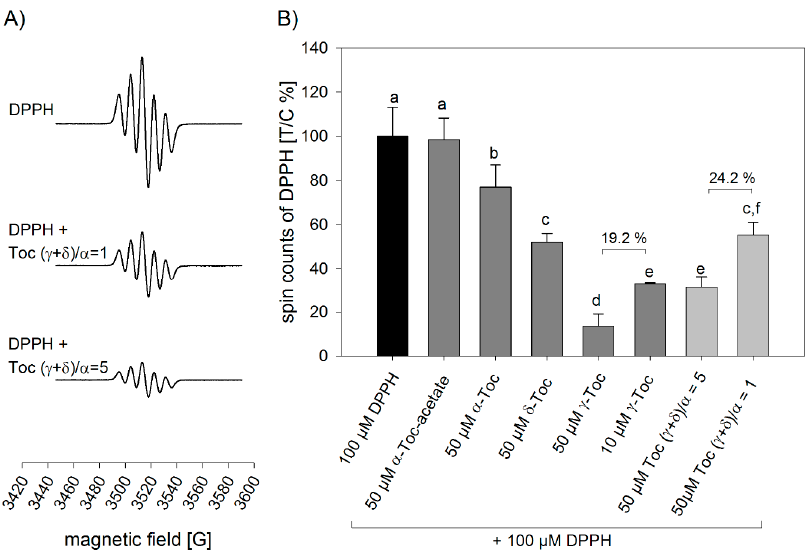
Figure 3. ( A ) ESR signals of DPPH and DPPH radical scavenging activity of 50 µM tocopherol ratio ( γ + δ )/ α = 1 and 50 µM tocopherol ratio ( γ + δ )/ α = 5 and ( B ) spin counts of DPPH. After three minutes spin counts of 100 µM DPPH (control = 100%) alone or in presence of 50 µM α -tocopheryl acetate ( α -Toc acetate), 50 µM α -tocopherol ( α -Toc), 50 µM δ -tocopherol ( δ -Toc), 50 µM γ -tocopherol ( γ -Toc), 10 µM γ -tocopherol ( γ -Toc), 50 µM tocopherol ratio ( γ + δ )/ α = 5 and 50 µM tocopherol ratio ( γ + δ )/ α = 1 were analyzed. Data are presented as mean ± SD ( n = 3). Statistically significant differences were analyzed using one-way ANOVA ( p ≤ 0.001) followed by Holm-Sidak post hoc test ( p < 0.05). Different letters indicate significant differences.